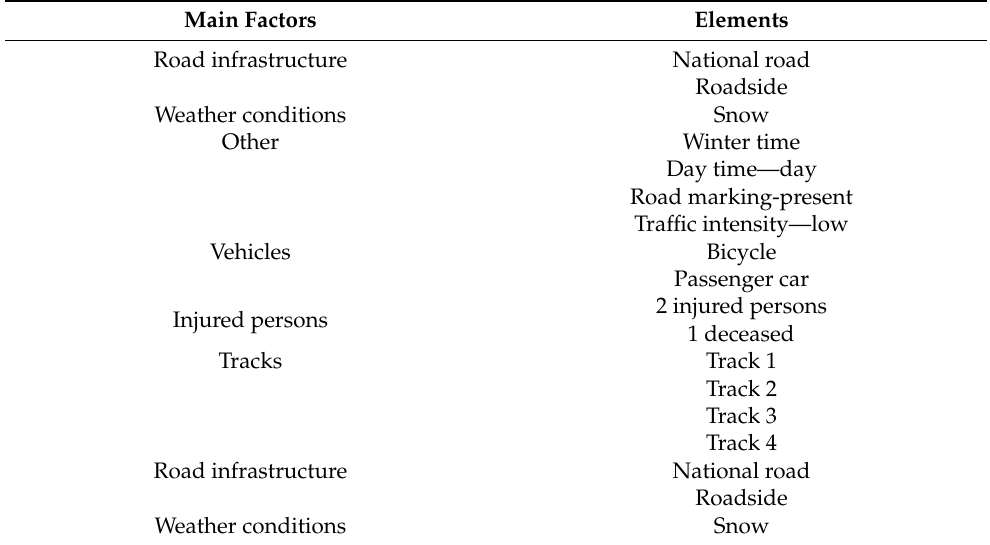
Table 7. Scenario